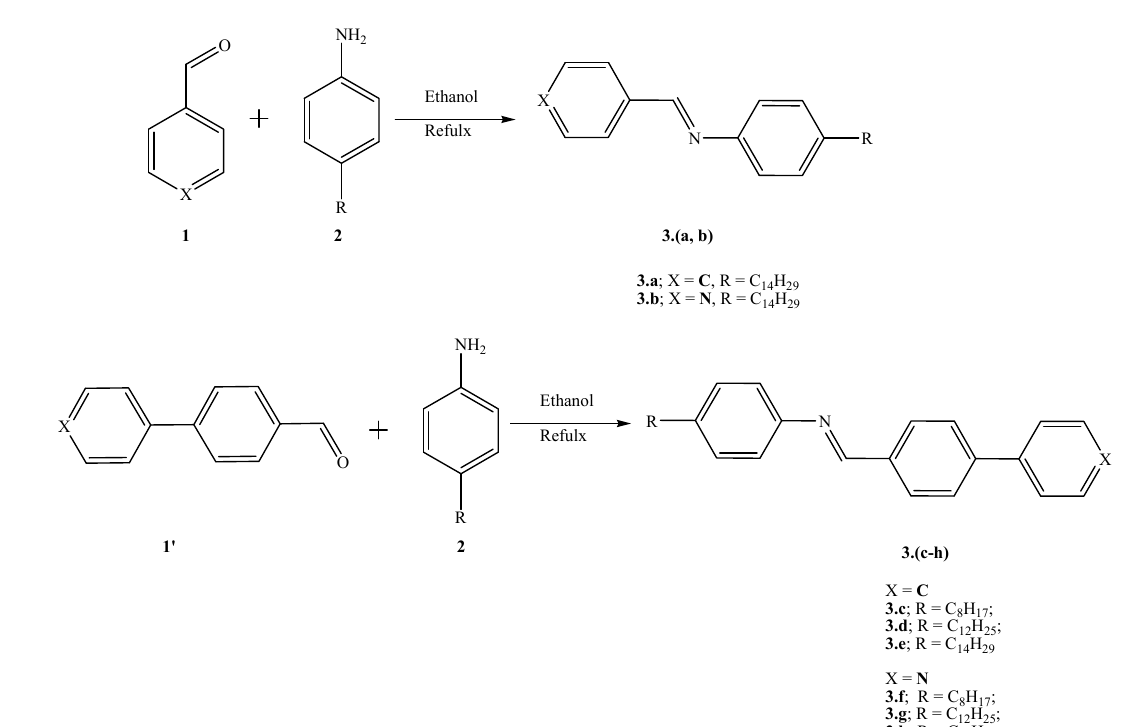
Scheme 1. Synthesis of N-arylidene-4-alkylbenzenamine 3.a – 3.h. 2.1. Synthesis of N-arylidene-4-alkylbenzenamine (